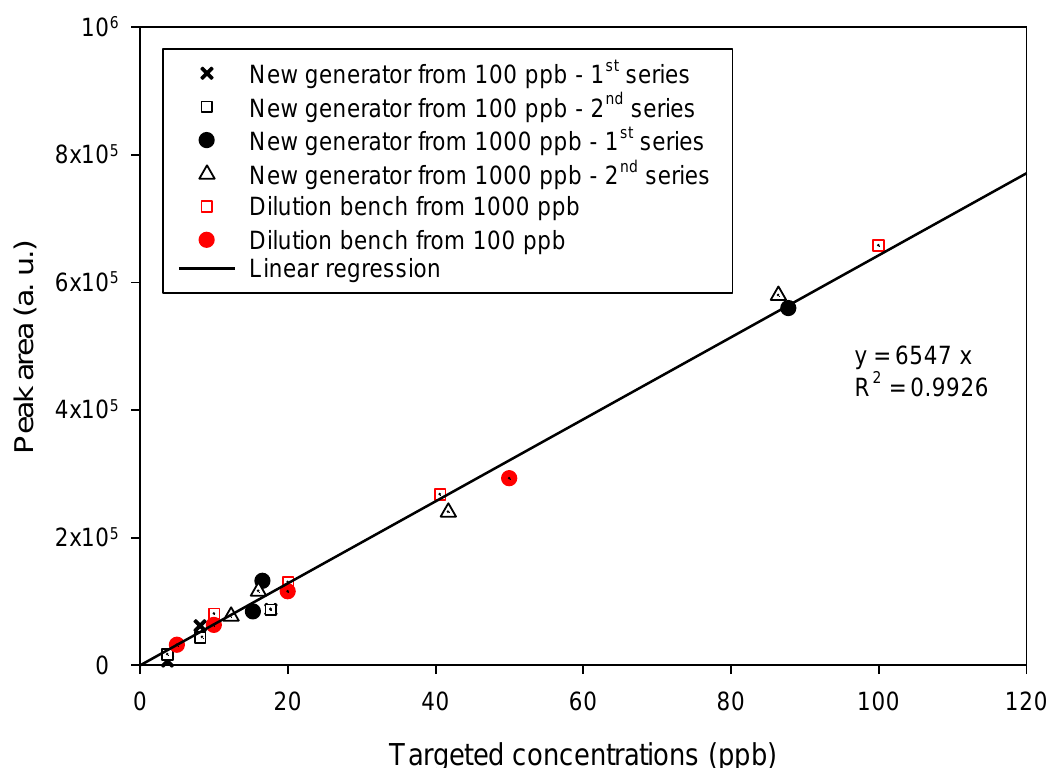
Figure 7. Comparison of the results obtained with the dilution bench and the novel source of gas mixtures based on a gas train generator coupled to a 4-stage micromixer, both using a gas cylinder of BTEX at 100 or 1000 ppb of each compound. The plot represents the experimental chromatographic peak area vs. the targeted concentration. The red symbols correspond to the data obtained with the dilution bench while the black ones were obtained with the experimental generator equipped with a 4-stage micromixer. The flow rate was fixed at: Q = 25 NmL min −1 . P pol varied from 100 to 2000 mbar and t carrier varied from 1 to 9 s.